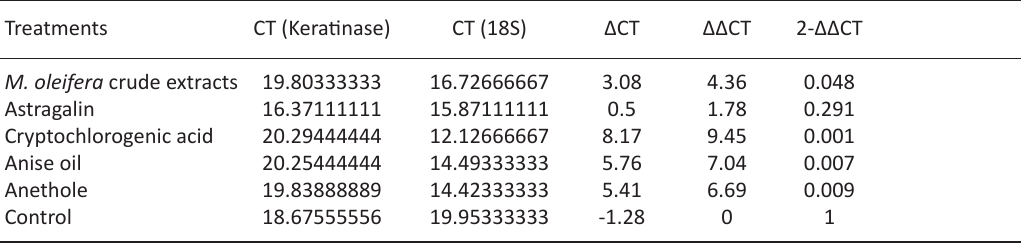
Fig. 3. The effects of plant extracts (Control , M. oleifera , Astragalin, Cryptochlorogenic acid, Anise oil and Anethole) on the keratinase gene expression of T. rubrum KP979791 (A) and KP979787 Table 2A. The analysis of the Keratinase gene’s relative gene expression for the T. rubrum KP979791 (ΔΔCT) Technique